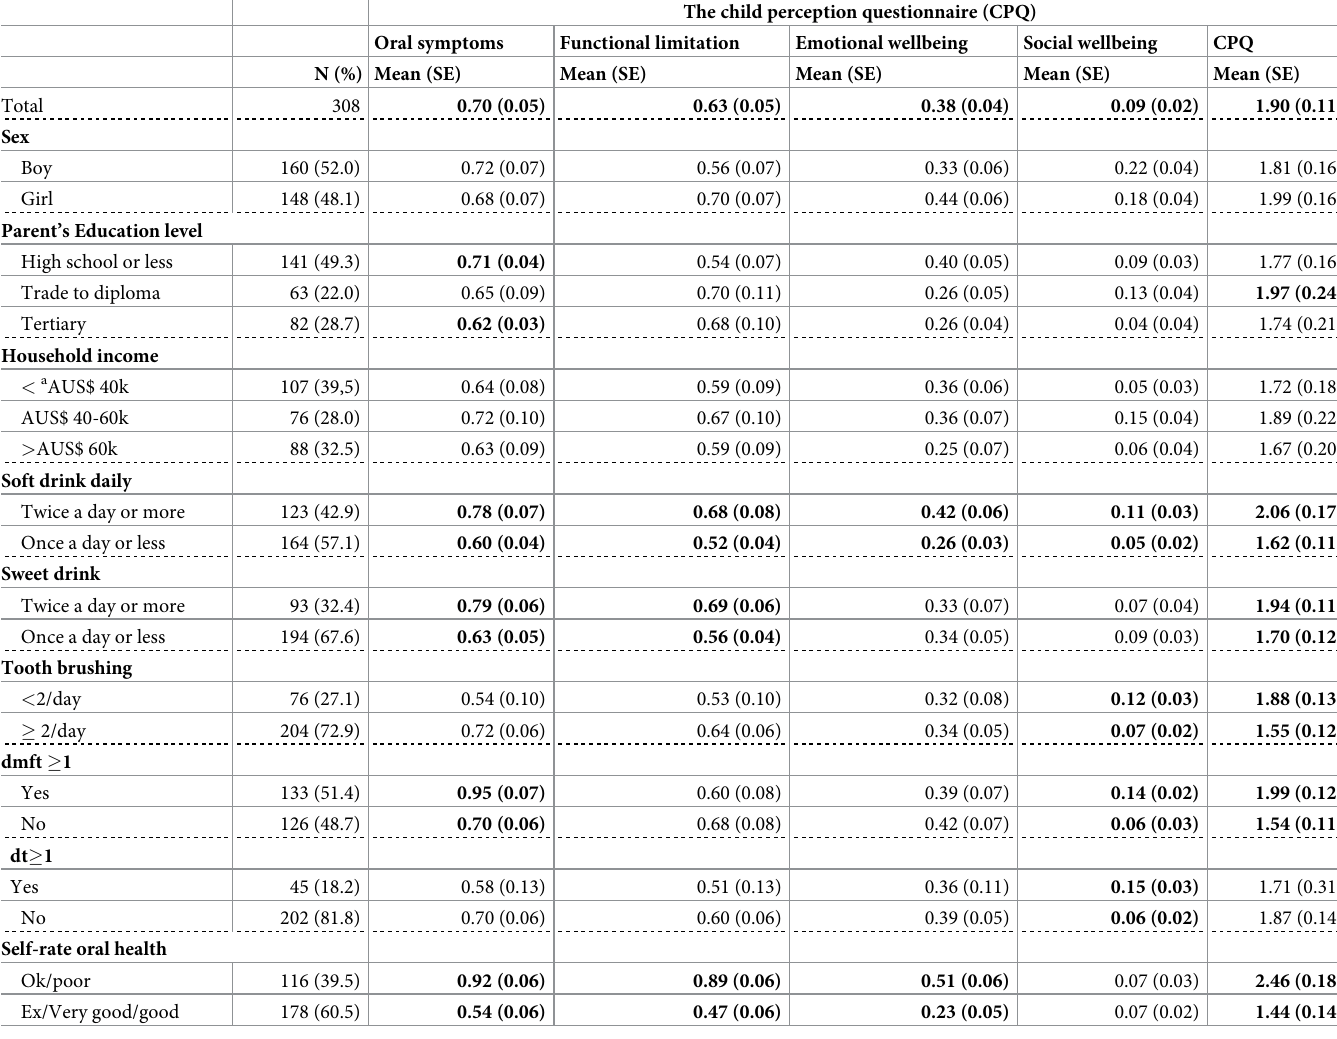
Table 5. Mean (SE) scores for 4-item CPQ and individual items by sample characteristics among children aged 8–10 years.